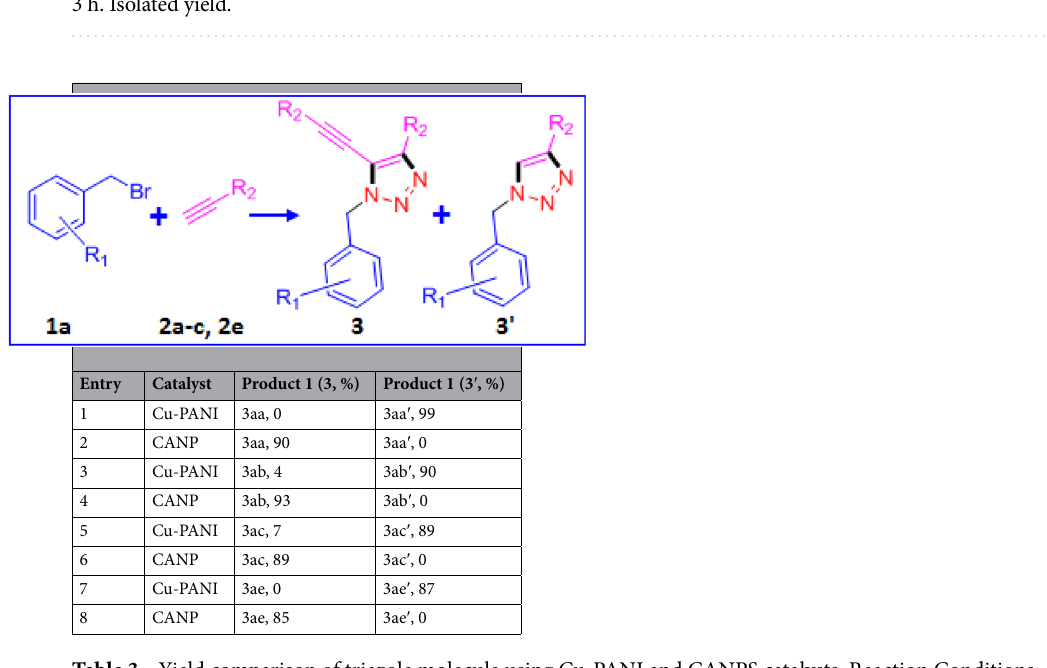
Table 2. Substrate scope for electron withdrawing group attached terminal alkynes. Reaction condition: Aryl bromide (1.0 eqv.), CANP (1.0 eqv. 200 mg), Terminal alkyne (1.0 eqv.), MeOH (4 mL), Et 3 N (1.0 eqv.), 25 °C, 3 h. Isolated yield.